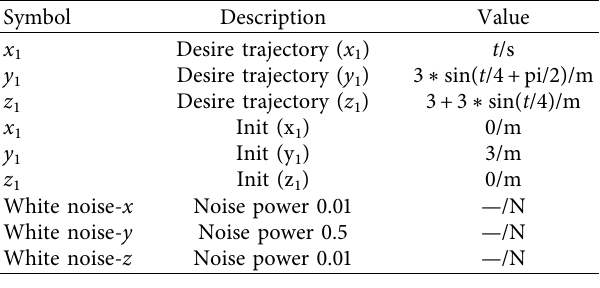
Table 5: Parameters of desire trajectory.